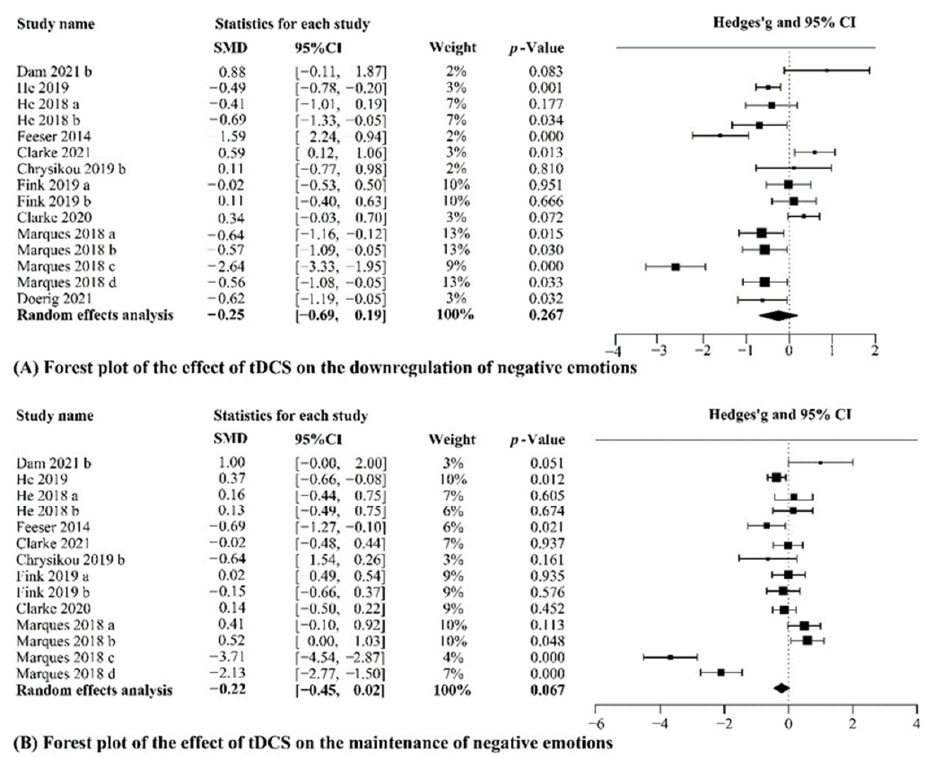
Figure 4. Results of the meta-analyses for tDCS studies. (a–d) Different effect sizes from the same